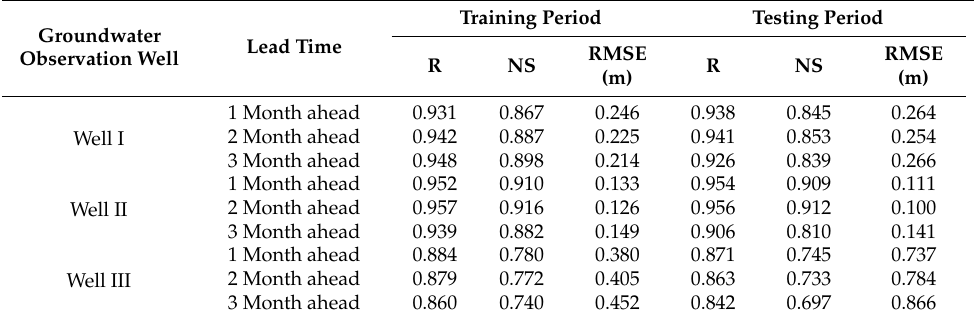
Table 3. The performance metrics of the ensemble BMA model for 1-, 2-, and 3-month-ahead GWL predictions for Wells I, II, and III in the training and testing